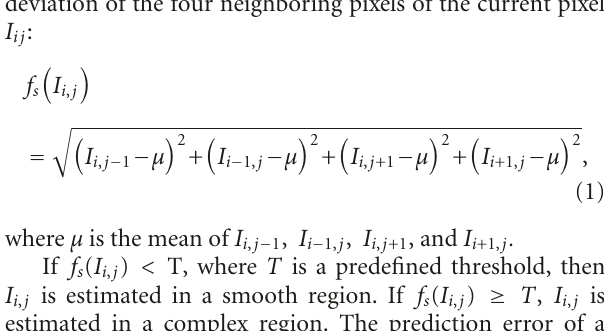
Figure 4: An illustration of embeddable and nonembeddable errors: (a) an illustration; (b) locations of embeddable and nonembeddable errors in a prediction error